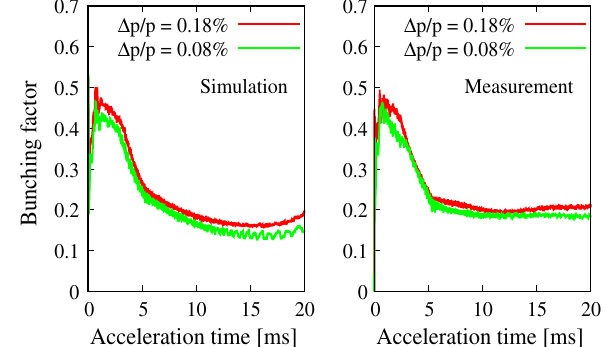
FIG. 22. Simulated (left) and measured (right) results of bunching factor B f with rms injected Δ p / p of 0.18% and 0.08% as shown by the red and green lines, respectively.